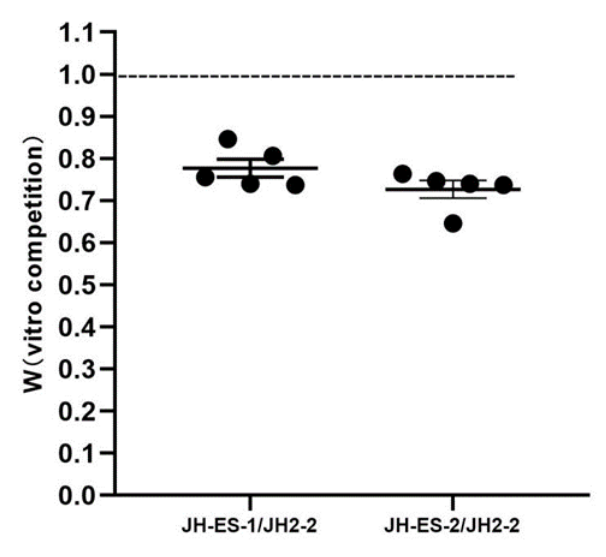
Figure 3. The relative competitive fitness W of the donor JH-ES-1 and JH-ES-2 with the recipient JH2-2 in vitro competition assays. The values were represented as mean ± SD of 5 independent parallels.